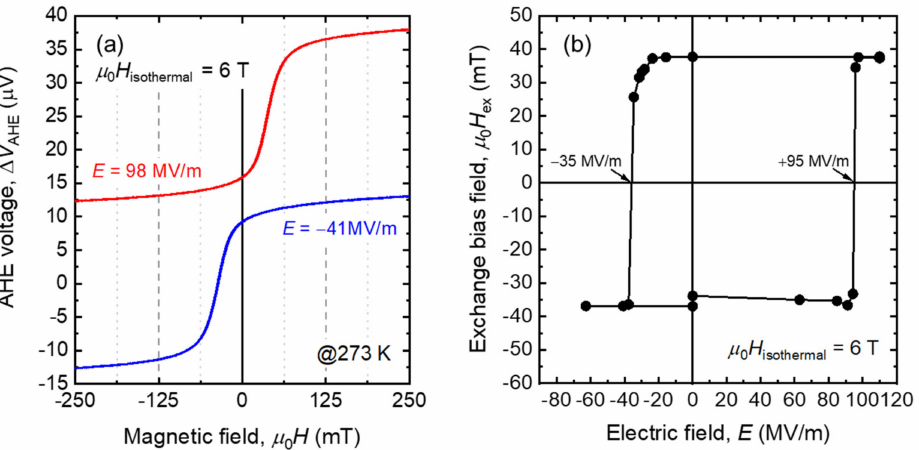
Figure 5. ( a ) AHE loops as a function of µ 0 H after the applying the magnetoelectric (ME) fields in an isothermal way. Blue and red curves represent the AHE loop after applying E = +98 MV/m and − 41 MV/m with µ 0 H isothermal = 6 T, respectively. ( b ) Change in the exchange bias field as a function of E with µ 0 H isothermal = 6 T. In ( b ), the threshold electric field is shown by